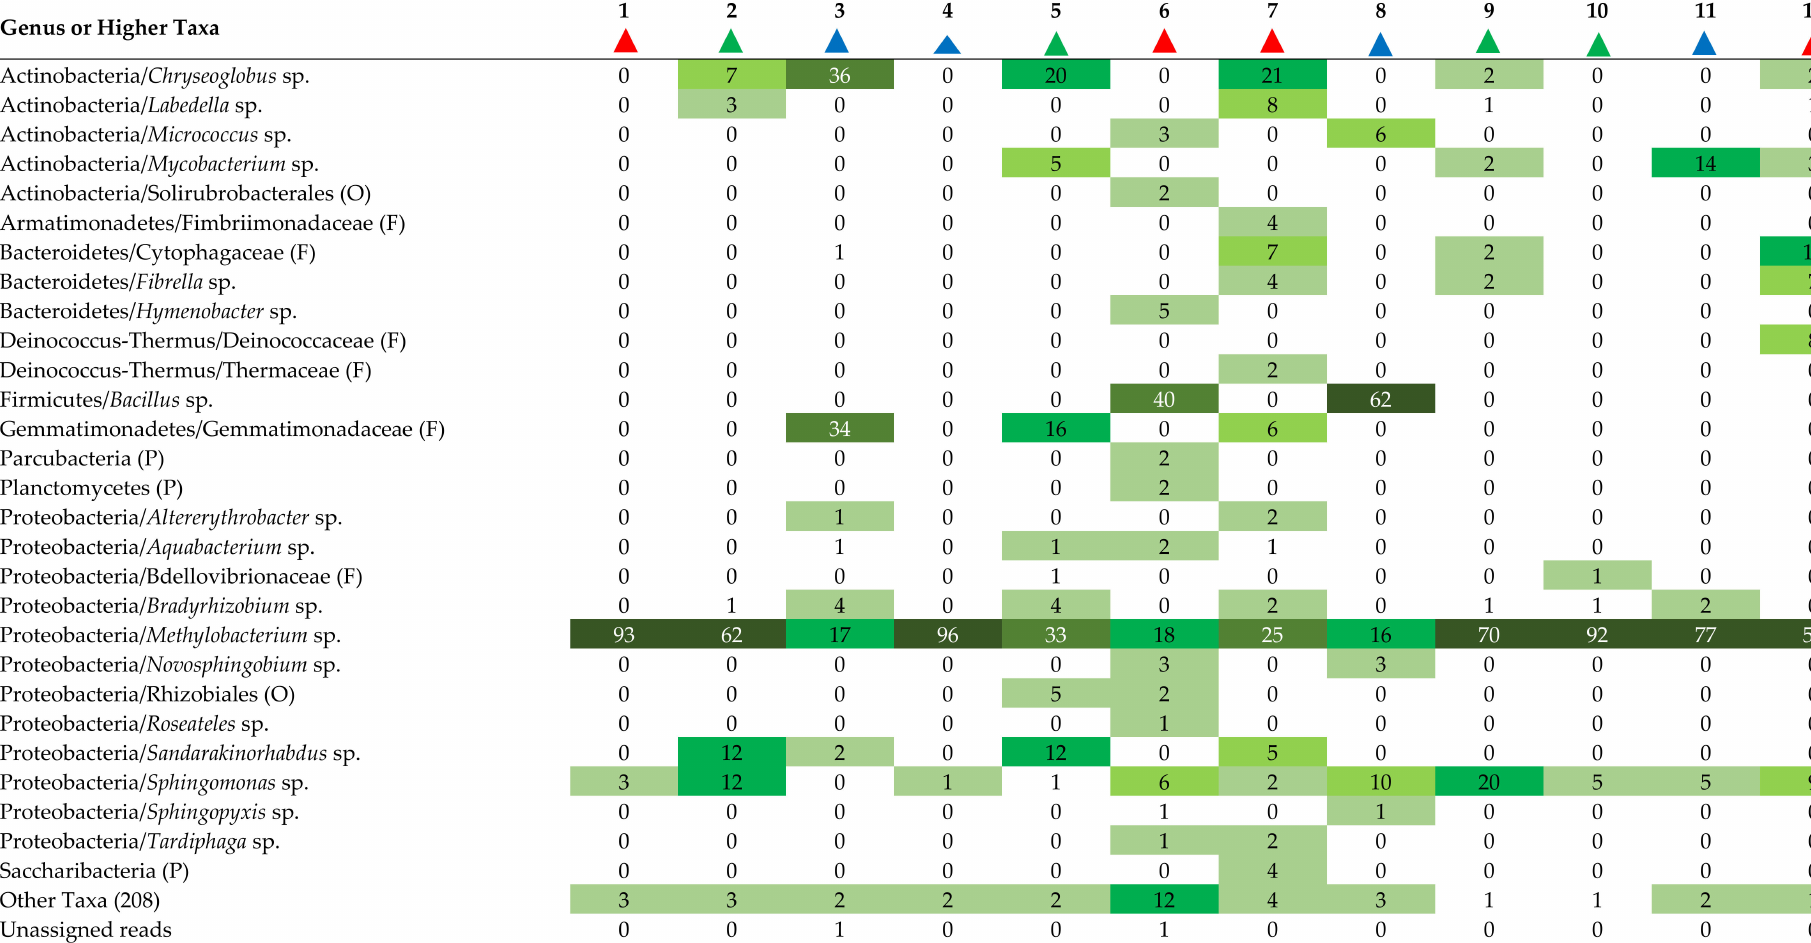
Figure 5. Heatmap showing the distribution of bacteria at the genus level and at higher taxa levels in biofilm from drinking water fountains. The letters in brackets correspond to family (F), order (O), class (C) and phylum (P). The numbers indicate the relative abundance (%) of each taxon at each site. Fountain types are A (green), B (blue) and C